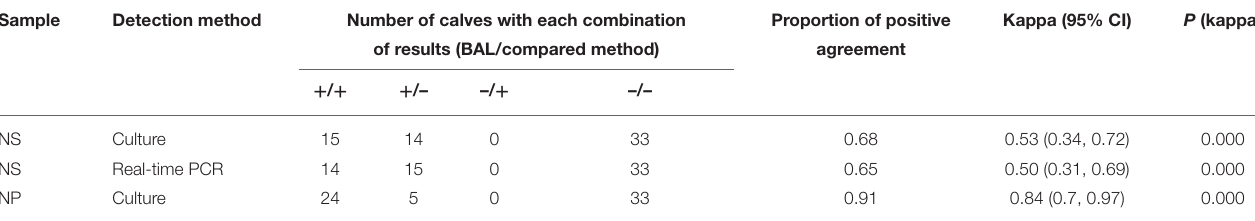
TABLE 1 | Agreement between bronchoalveolar lavage (BAL) and nasal swab (NS) or deep nasopharyngeal swab (NP) in detecting M. bovis in 62 calves with acute respiratory disease. Sample